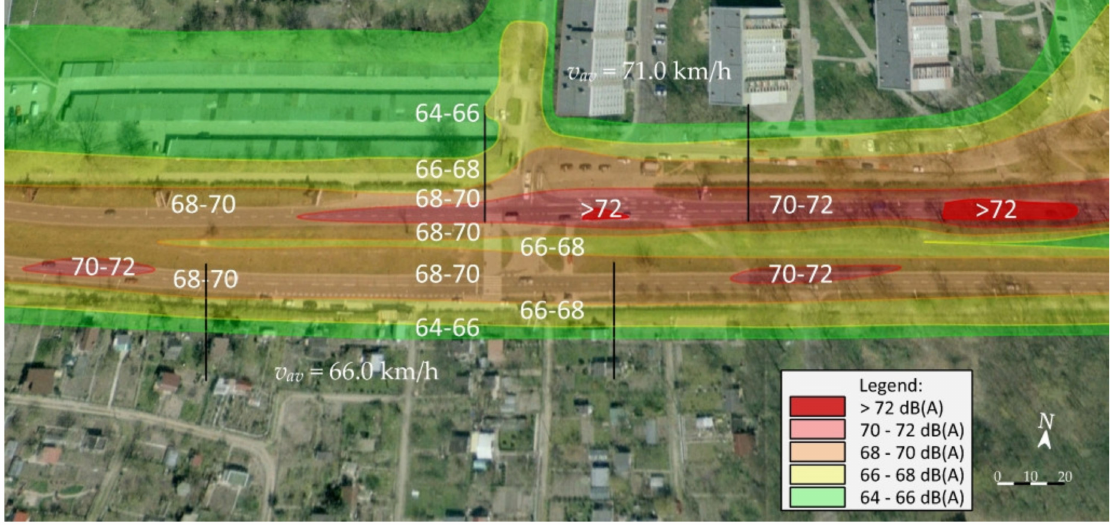
Figure 11. Noise map showing the situation before the implementation of the lane narrowing treatment on the analysed urban dual carriageway.